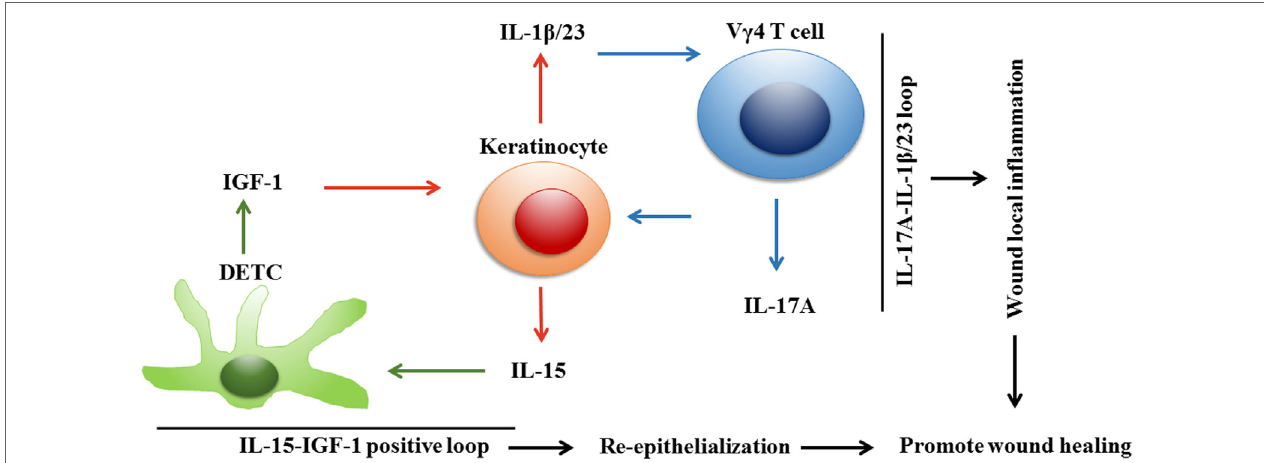
FiGURe 1 | Dendritic epidermal T cells (DETCs), keratinocytes, and V γ 4 T cells constitute two correlated loops to improve wound repair in diabetic mice. Upon skin injury in diabetic mice, keratinocyte-derived IL-15 increases IGF-1 production by DETCs, which in turn enhances keratinocytes to secrete IL-15. A positive correlation between IL-15 and IGF-1 is formed in wounded epidermis, and thereby amplifies IGF-1 production in epidermis for promoting re-epithelialization and wound healing. Meanwhile, keratinocytes could also interact with V γ 4 T cells, which infiltrate in epidermis to form an IL-17A-IL-1 β /IL-23 feedback loop to augment local inflammation for efficient skin wound healing. In the wounds of diabetic mice, DETC-mediated IL-15-IGF-1 correlation and V γ 4 T cell-mediated IL-17A-IL-1 β / IL-23 loop are coordinated to improve the defects of diabetic wound healing through enhancing re-epithelialization and local inflammation,